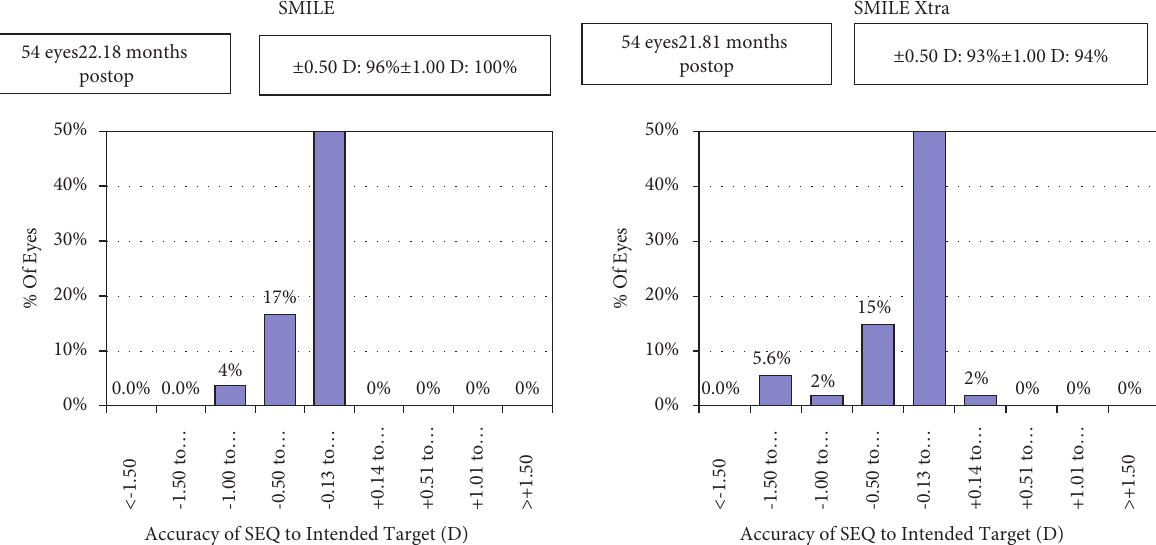
Figure 3: Histogram showing the accuracy to the intended spherical equivalent refraction.